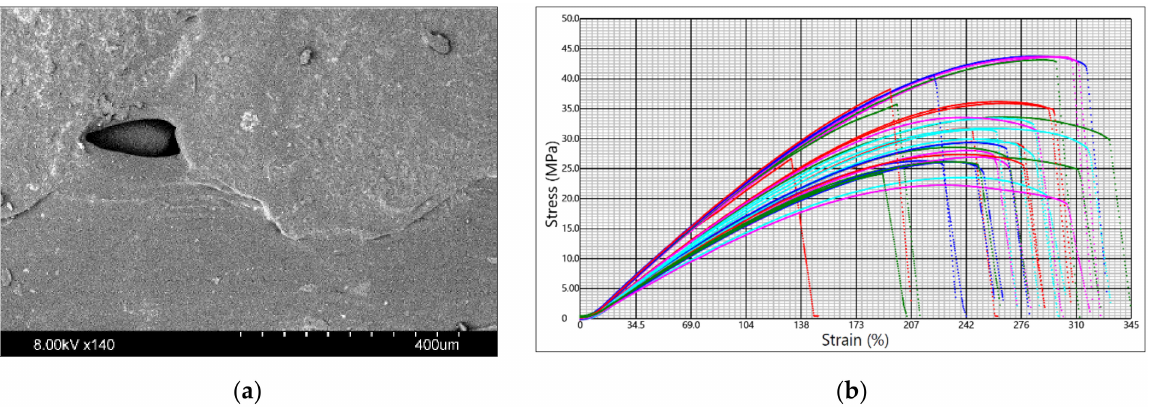
Figure 4. Prusament PETG Orange PPE: ( a ) sample surface SEM image; ( b ) tensile test